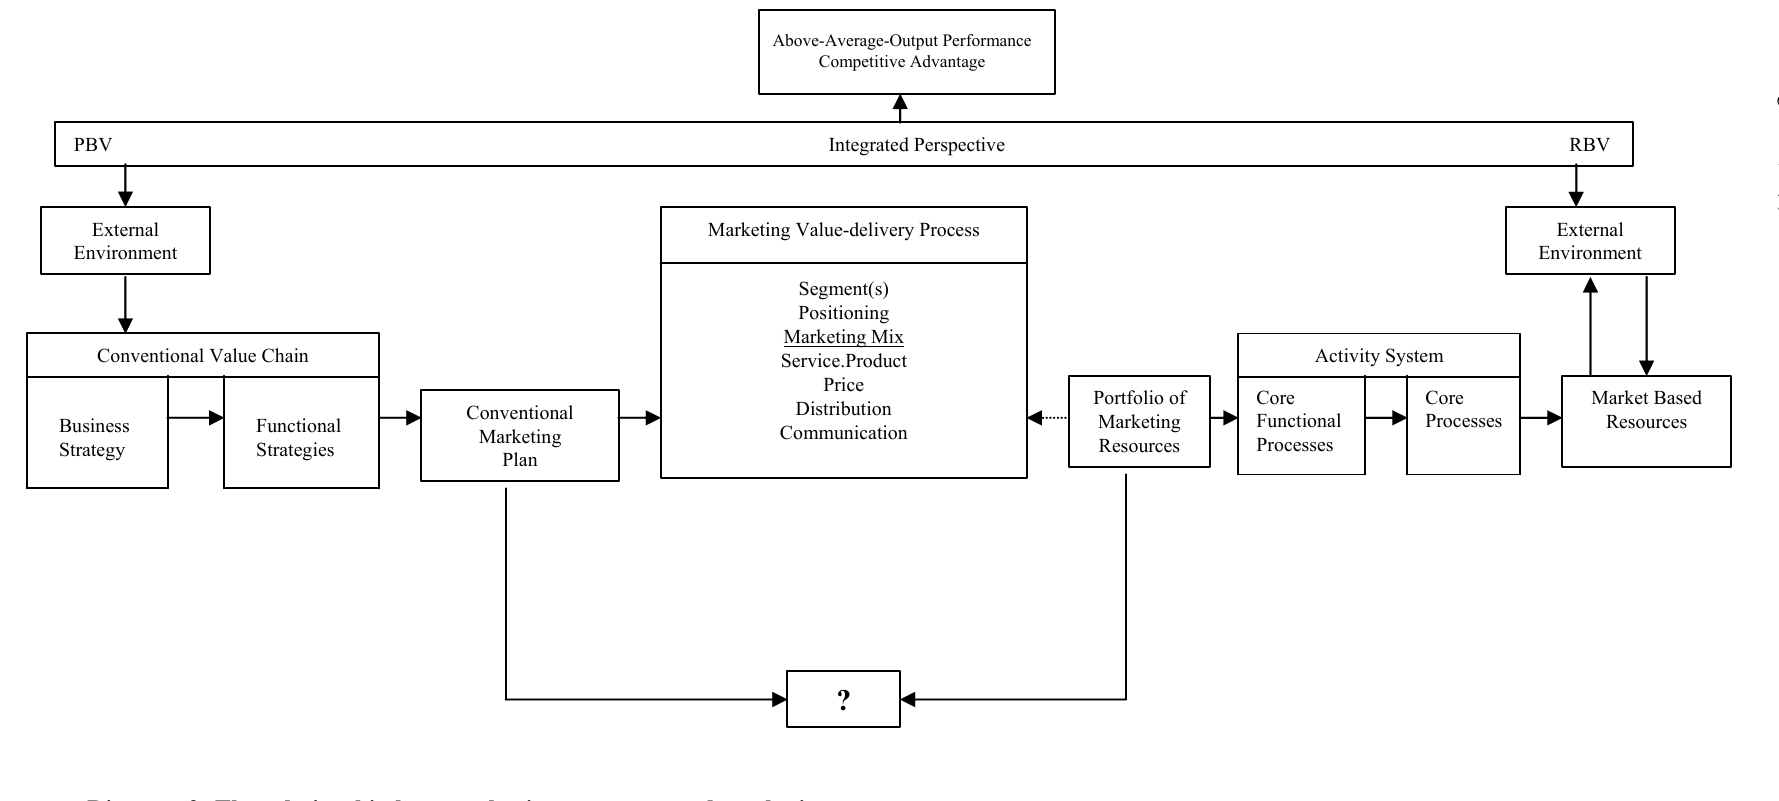
Diagram 2: The relationship between business strategy and marketing